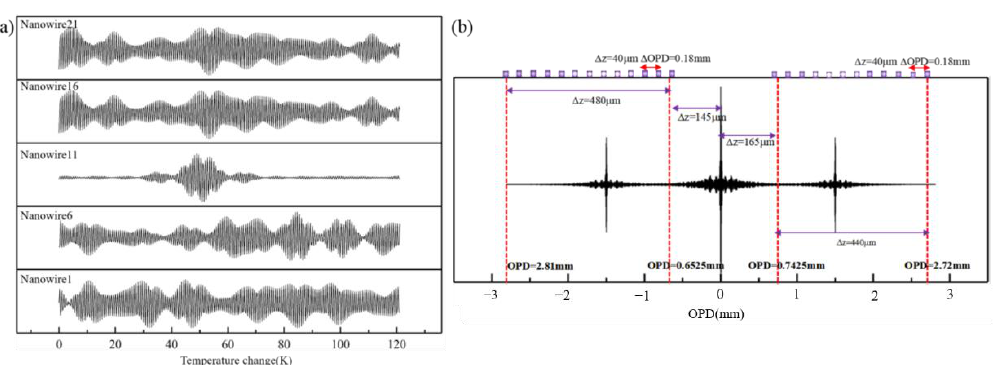
Figure 5. ( a ) Raman spectroscopy detection process. The corresponding sampling data of the 1st, 6th, 11th, 16th and 21st nanowires. ( b ) The position of the gold nanowires corresponding to the dynamic interferogram.